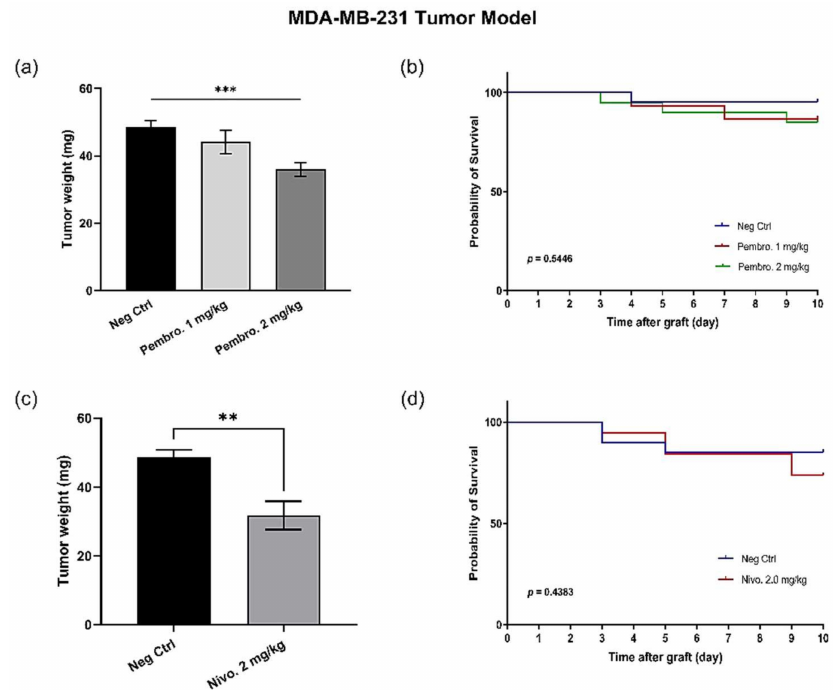
Figure 9. In ovo PD-1 inhibitors’ treatment in the MDA-MB-231 tumor model, ( a ) Pembrolizumab induced 8.87% of tumor growth inhibition at 1.0 mg/kg ( p = 0.444) and 25.8% of regression at 2 mg/kg ( p = 0.0007, ***); ( b ) No evident toxicity was induced by pembrolizumab treatment; ( c ) Nivolumab led to 34.77% of tumor growth regression ( p = 0.0031, **); ( d ) No evident toxicity was induced by nivolumab